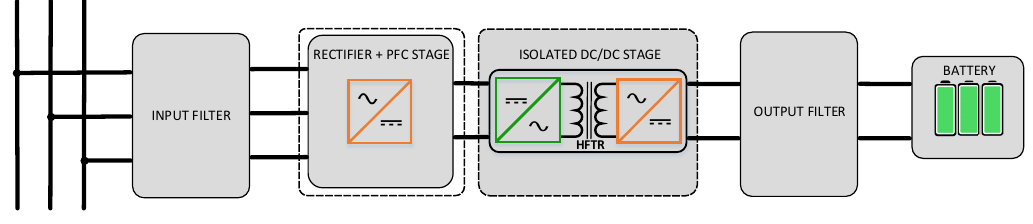
Figure 4. Basic blocks of DC fast charger power